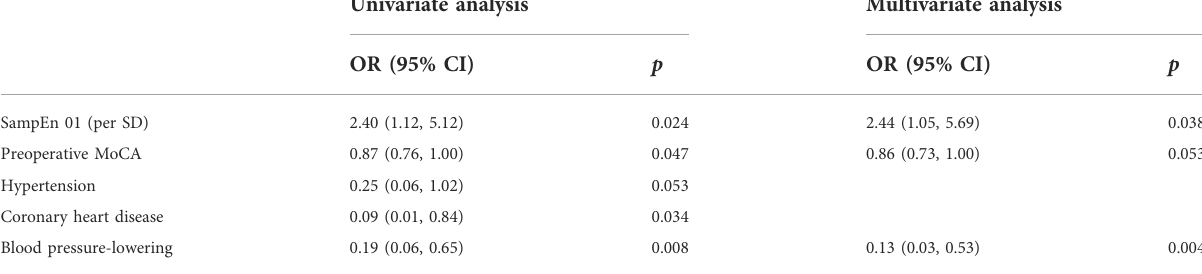
TABLE 3 Predictive power of selected variables for POCI using logistic regression